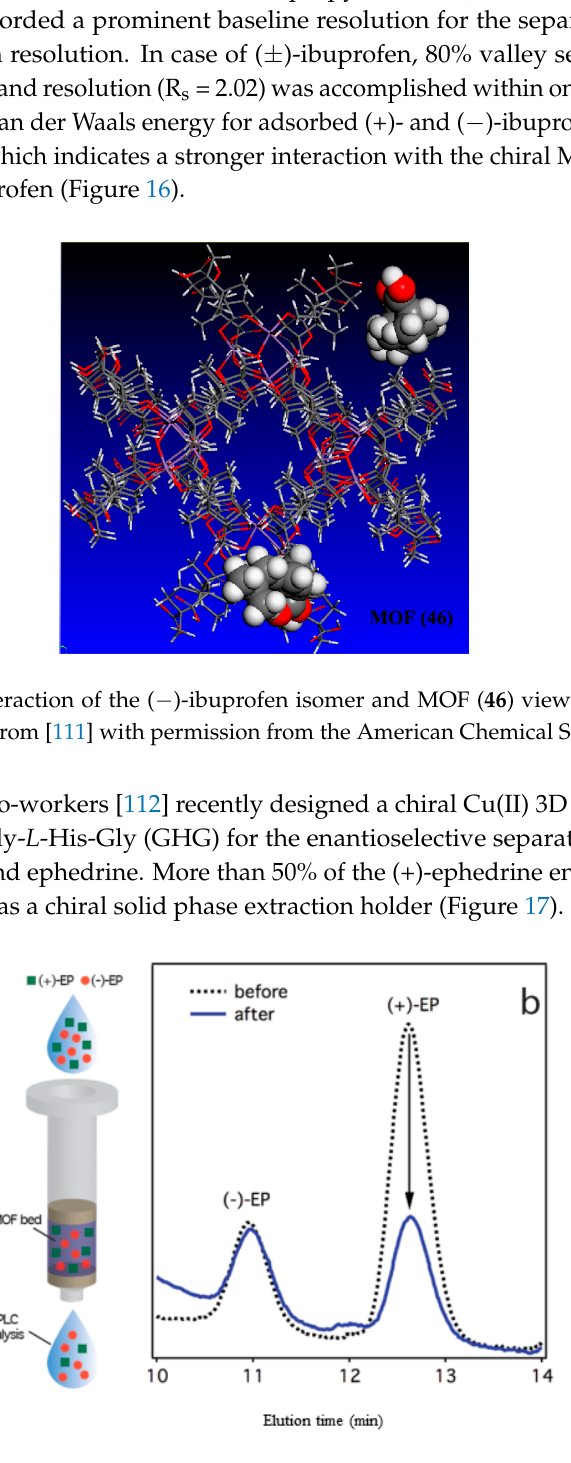
Figure 17. ( a ) Solid phase extraction separation of ephedrine by using MOF ( 47 ) as a chiral bed. ( b ) HPLC chromatograms of ephedrine racemate before (dashed line) and after (solid line) passing through the MOF bed. Reproduced from [112] with permission from the American Chemical Society.